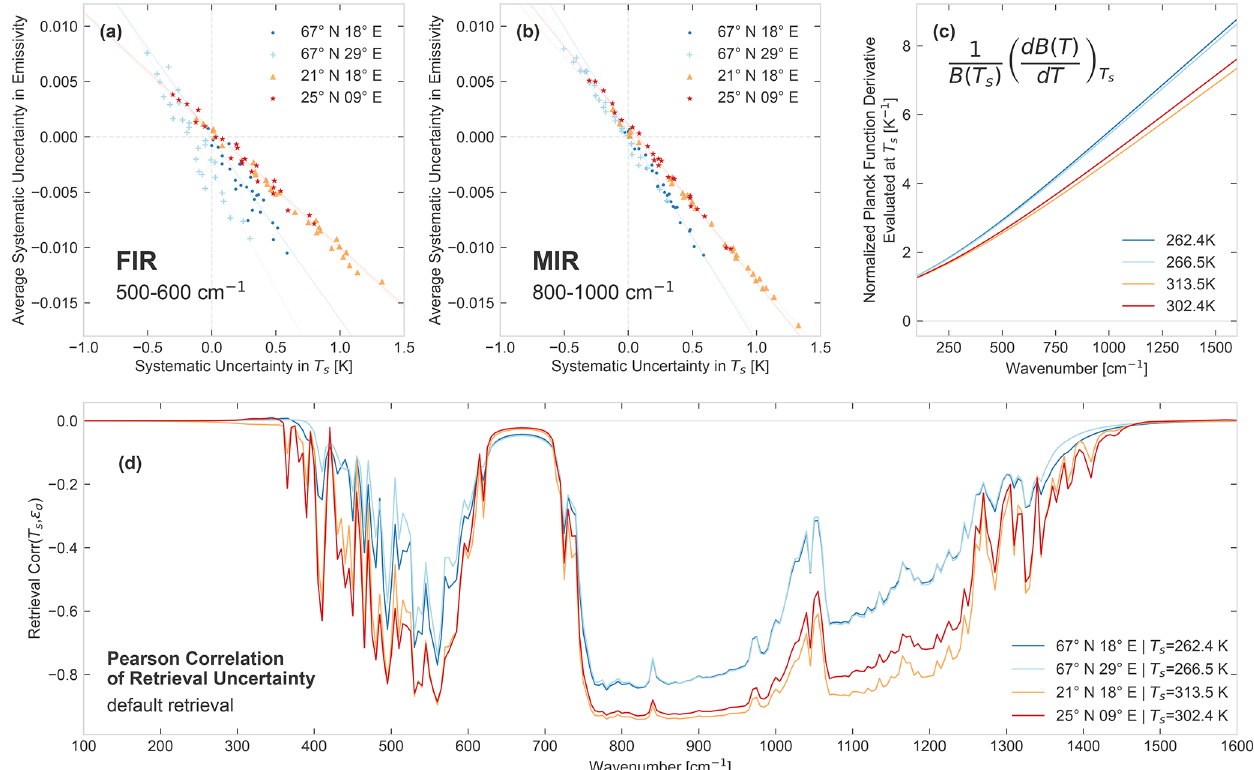
Figure C1. Correlation between emissivity and surface temperature in the atmospheric state retrieval. The four colour-coded scenes are shown (67 ◦ N, 18 ◦ E; 67 ◦ N, 29 ◦ E; 21 ◦ N, 18 ◦ E; and 25 ◦ N, 9 ◦ E) in dark blue, light blue, orange and red, respectively, with details as outlined in Sect. 3. Panels (a) and (b) show the retrieval systematic uncertainties for 28 retrievals of each scene. The baseline retrieval is run on spectra generated with six versions of random instrumental noise (seeds of 0 to 6) and for equal flat a priori cases and an initial guess set to 0.7, 0.8, 0.9 and 1.0. In panel (a) , the average systematic uncertainty in emissivity in the 500–600cm − 1 range is plotted against the systematic uncertainty in the surface temperature ( T s ). Light grey dashed lines show the true emissivity and T s . Table C1 details the slope of the linear trend fitted to the points (grouped by scene) and the sample Pearson’s correlation coefficient (see Eq. C1) for these data. The fitted trend is also plotted as a light line of the same colour as the corresponding data. Panel (b) is similar but with the 800–1000cm − 1 systematic emissivity uncertainty on the y axis. Its slope and correlation values are also detailed in Table C1. Panel (c) shows an analytic calculation /B(T s ) at the four different true surface temperatures of the scenes, of the value of the normalized Planck function derivative [ d B(T )/ d T ] T s plotted over the full FORUM spectral range. Panel (d) shows the analytic Pearson correlation coefficient (see Eq. C4) of the emissivity and T s retrieval uncertainty over the full FORUM spectral range for all four cases from the retrieval run, using the default setting outlined in Sect. 3. The correlation is calculated, as shown in Eq. (C4), from the retrieval uncertainty covariance matrix at convergence (see Eq.